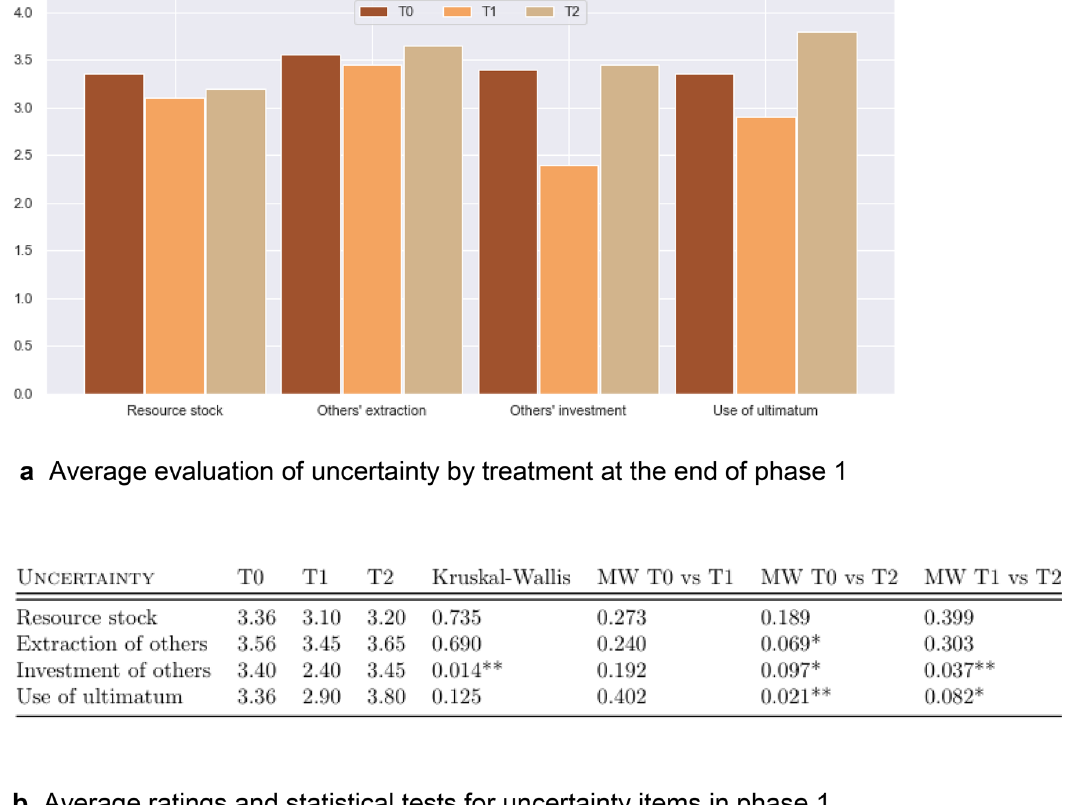
Figure 3. Average evaluation of uncertainty by treatment in phase 1 and statistical